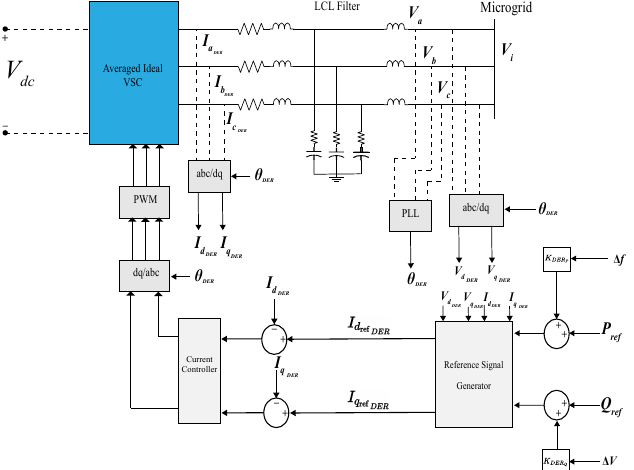
Figure 2. Type 4 wind generator voltage source converter (VSC) average model based on (Reprinted/ adapted with permission from Ref. [18]. 2021,